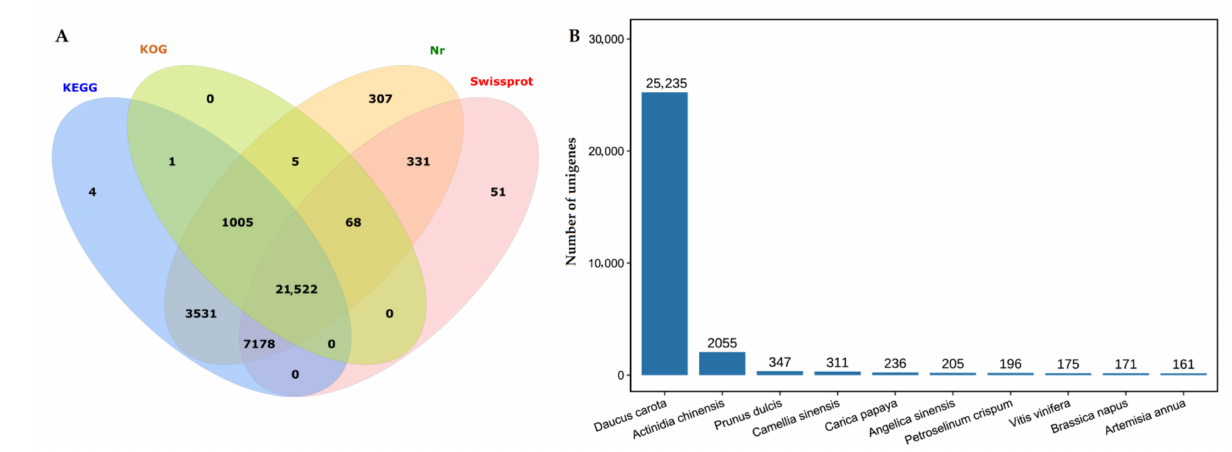
Figure 4. Basic annotation of the isoforms based on KEGG, KOG, Nr and SwissProt databases ( A ) and the top 10 species distribution against Nr ( B ).